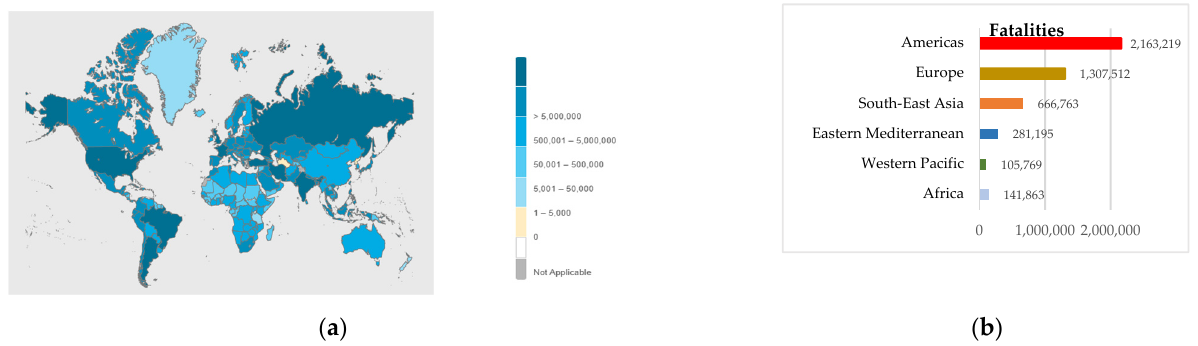
Figure 1. Cumulative COVID-19 ( a ) confirmed cases and ( b ) the fatalities by territory and area [1] (accessed on 19 September 2020).